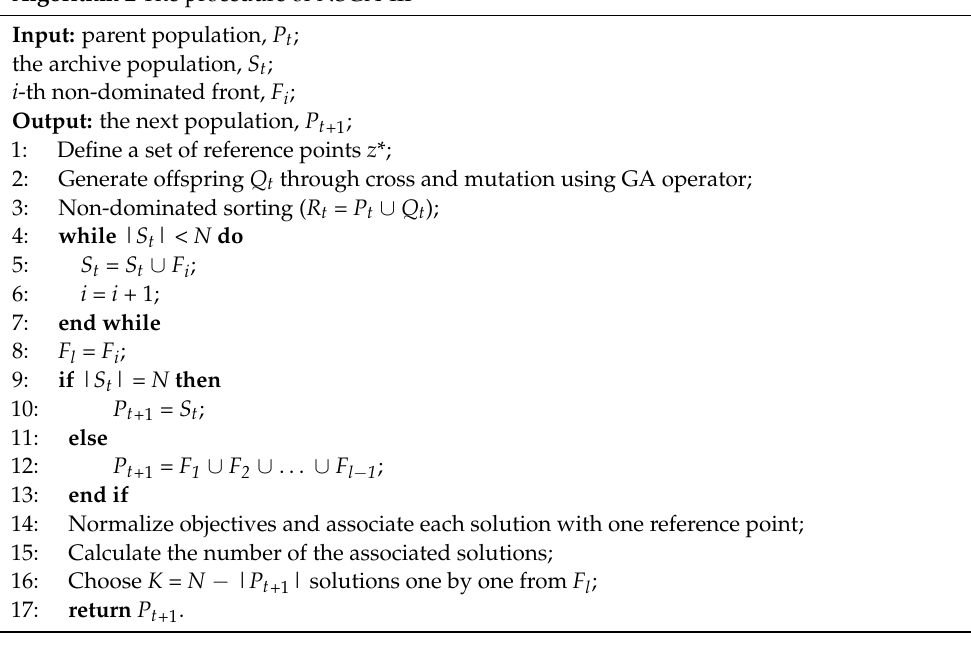
Algorithm 2 The procedure of